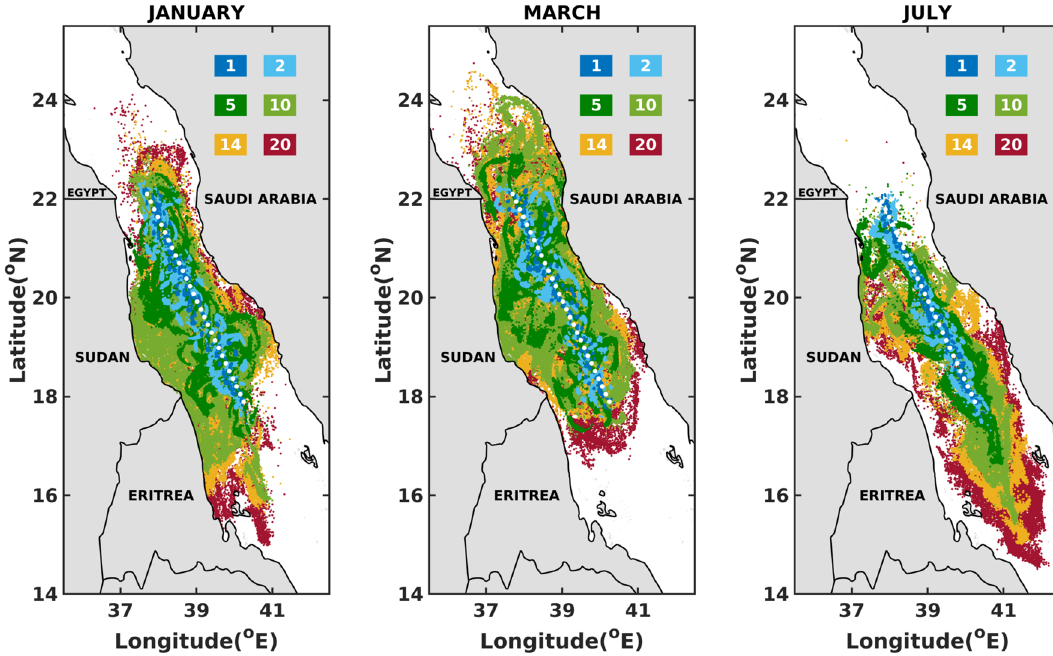
Figure 4. Superposition maps for the one (1), two (2), five (5), ten (10), fourteen (14) and twenty (20) days after the commencement of the spill, in the Central Red Sea. The figures were created on Matlab-r2020b (https:// matlab- r2020b. softw are. infor mer. com).